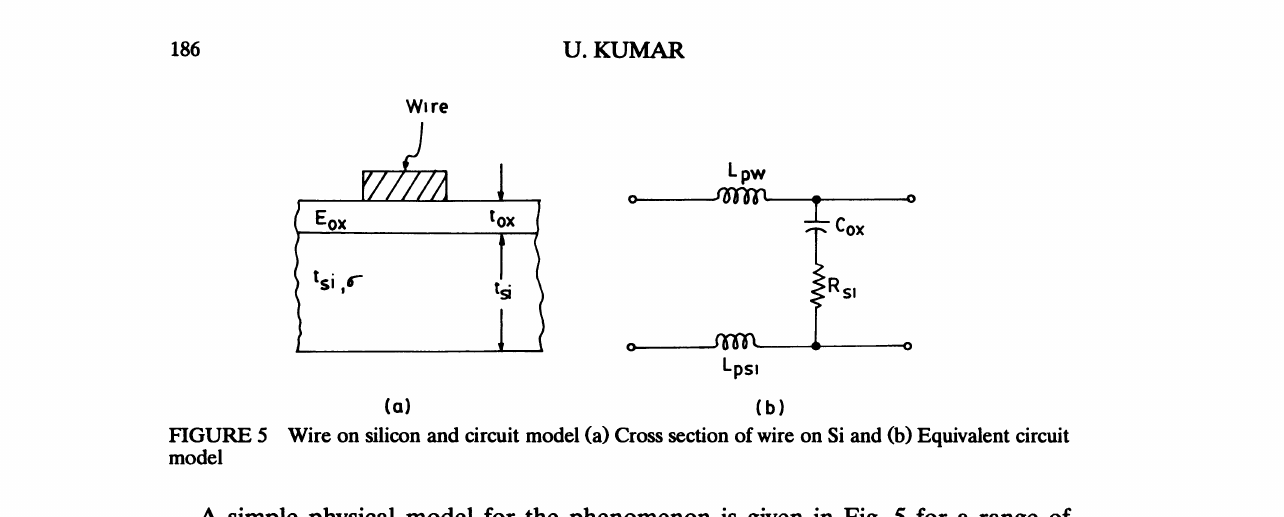
FIGURE 5 Wire on silicon and circuit model (a) Cross section of wire on Si and (b) Equivalent circuit